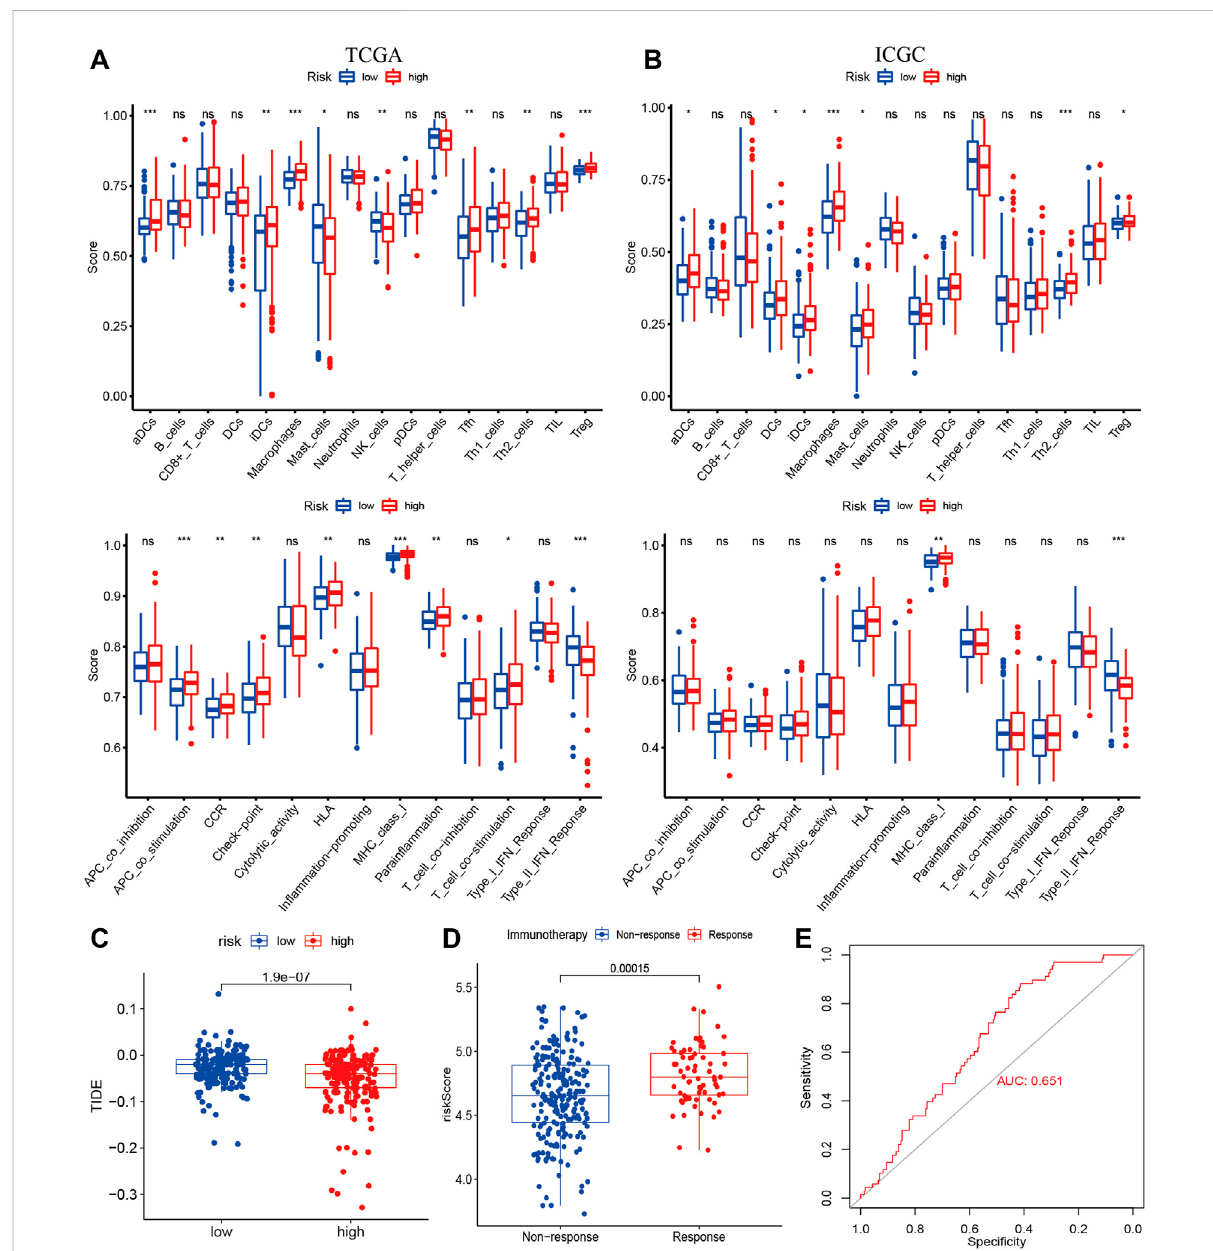
FIGURE 7 Immune Status and Prediction of response to immunotherapy. The enrichment scores of 16 immune cells and 13 immune-related pathways between subtypes in the TCGA (A) and ICGC cohorts (B) ; (C) The TID scores between high- and low-risk groups in the TCGA cohort; (D) The risk score between immunotherapy response group (PR/CR) and non-response group (PD/SD) in IMvigor210; (E) ROC analysis for predicting immunotherapy